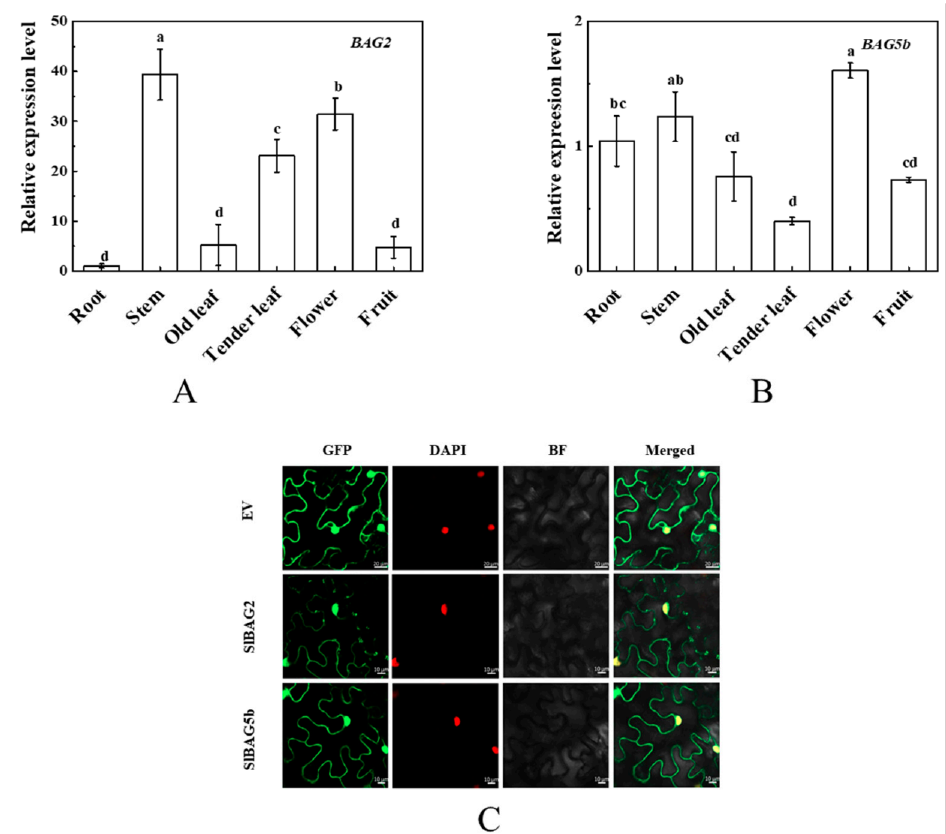
Figure 6. Tissue-specific expression analysis of BAG2 and BAG5b in tomato and subcellular localiza- tion. ( A , B ): The expression levels of BAG2 and BAG5b in the root, stem, old leaf, tender leaf, flower, and fruit of tomato. The expression level in the root was set as 1.0. Data represent the means ± SE of three replicates. Different letters represent expression levels that were significantly different at P < 0.05; ( C ): subcellular localization of BAG2 and BAG5b in tobacco cells. The CDS of BAG2 and BAG5b without a stop codon was inserted into the vector pFGC5941-GFP. The empty vector (EV) was used as a